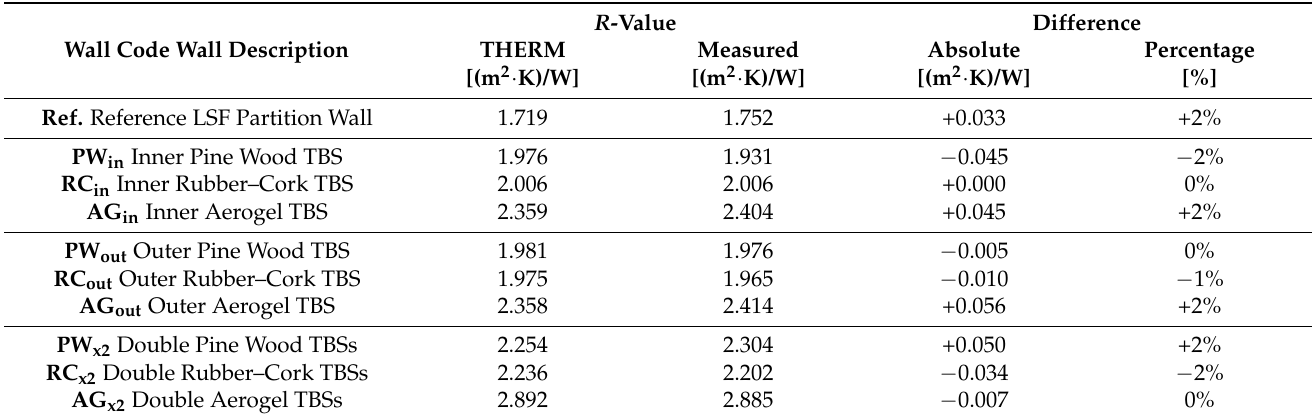
Table 3. Numerical (THERM) and experimental (measured) thermal resistances (conductive R -values).